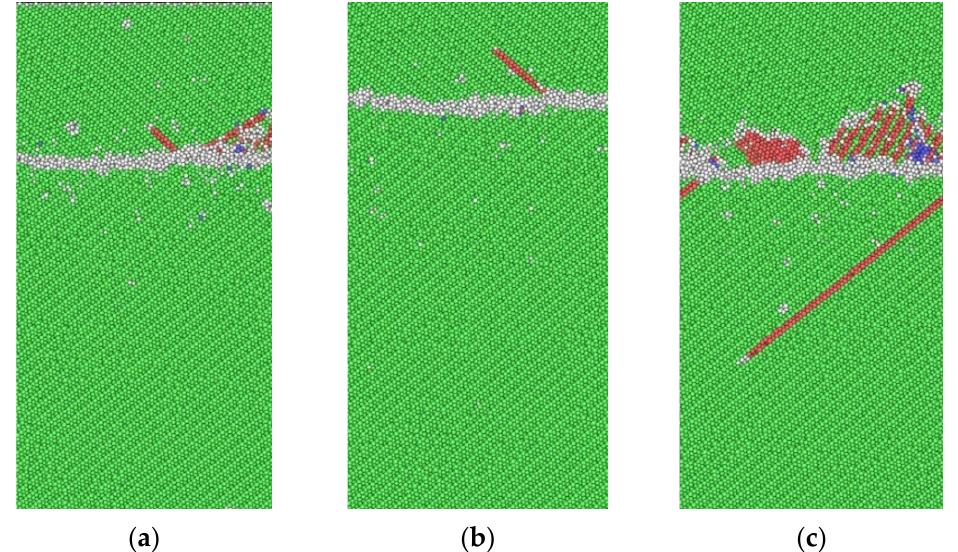
Figure 5. Positions of the welding interface in Model II after five cycles of sinusoidal sliding under the clamping pressure of 67 ( a ), 135 ( b ), and 270 MPa ( c ). Atoms are colored according to their local crystalline structure (see description in text). The whole computational cell is presented in each case.